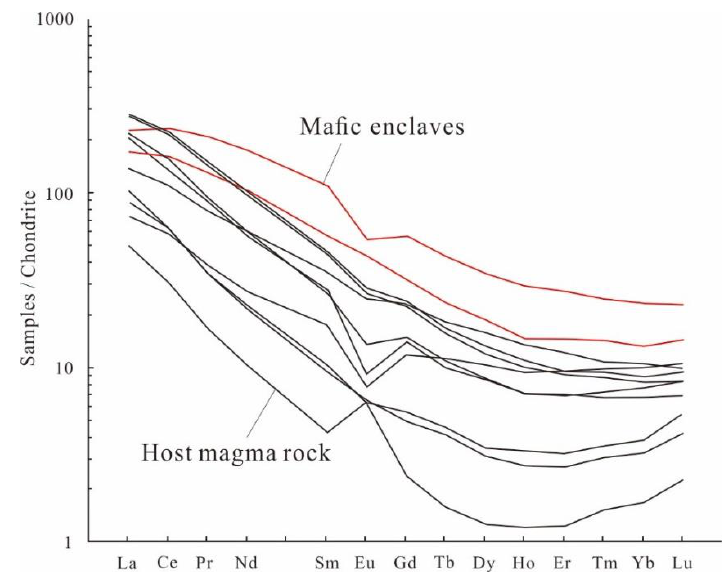
Figure 8. Chondrite-normalized rare earth elements (REE) patterns of the mafic enclaves (pink) and the Qingshanbao host rock (grey) (Chondrite data after Taylor and McLennan [40]).